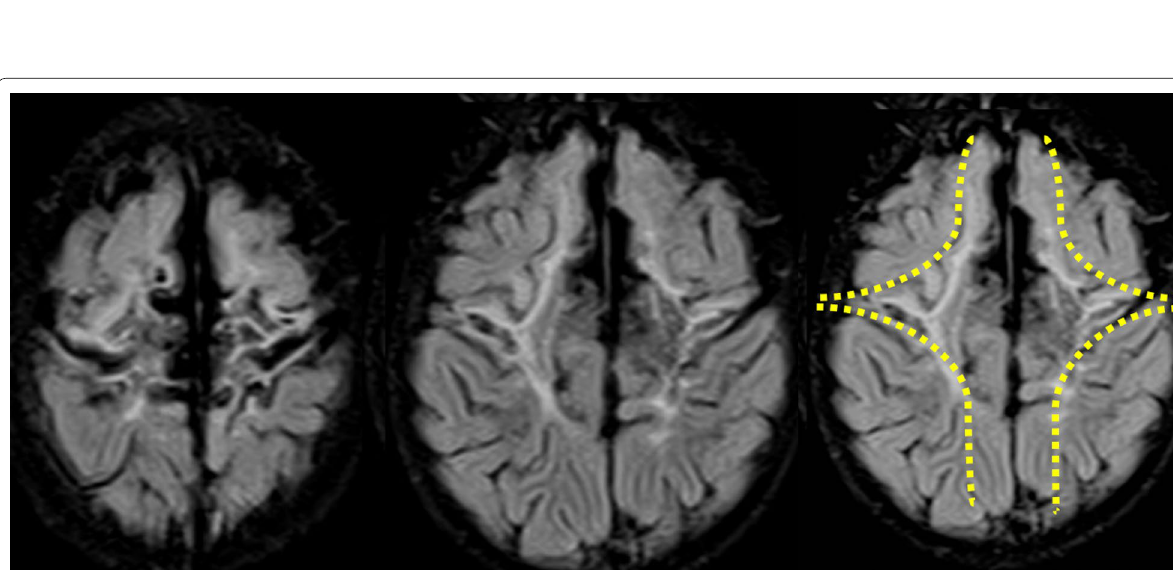
Fig. 5 The MPI subtype of parasagittal cortex injury including complete destruction of the SMA, with secondary diamond‑shaped (yellow dotted line) expansion of the interhemispheric